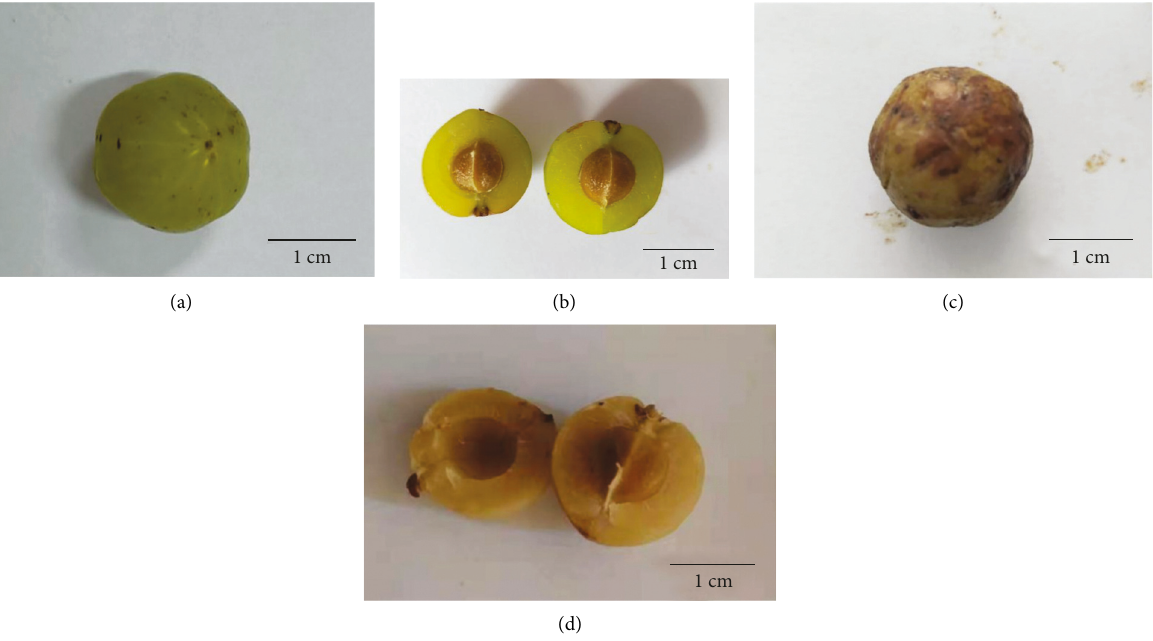
Figure 1: The comparison of the browning area ((a, b) grade 0, and (c, d) grade 4). Note: when the browning index is 1, it can be expressed as complete